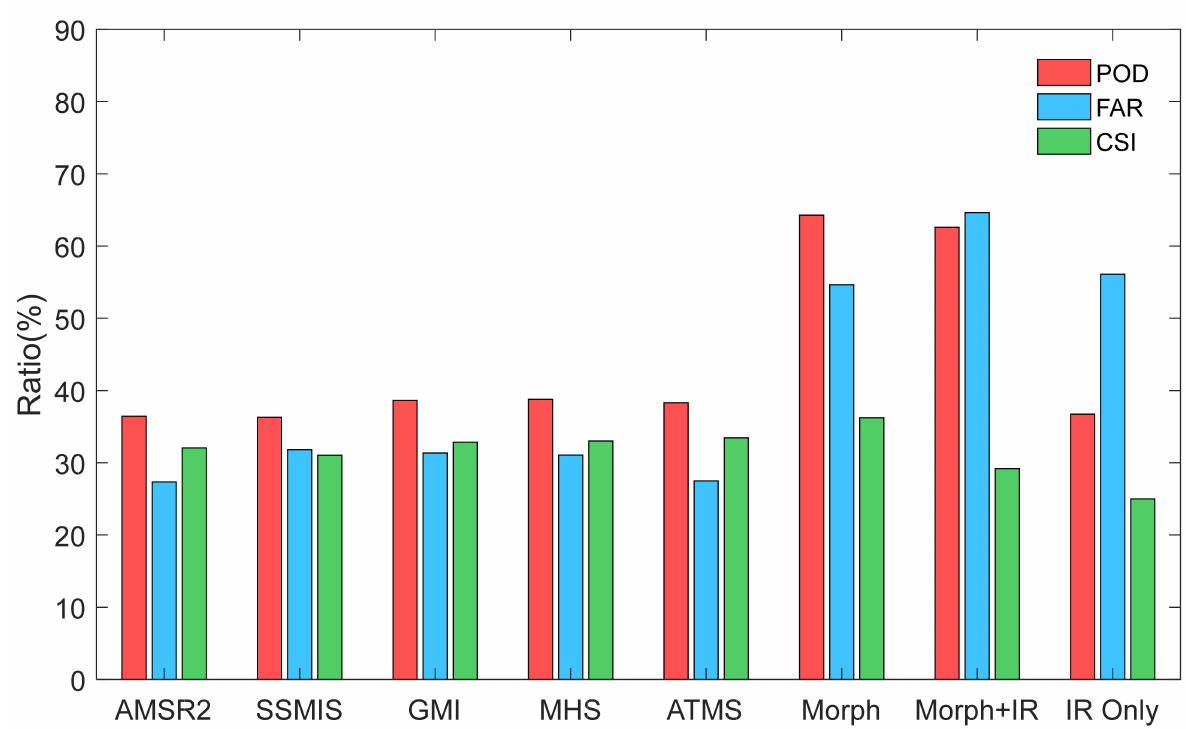
Figure 5. The POD, FAR, and CSI for each input source used in